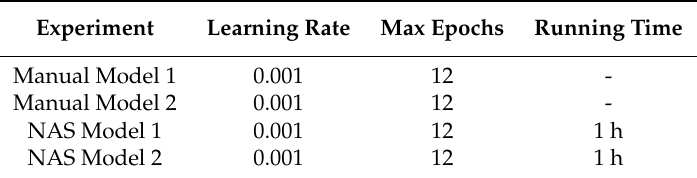
Table 3. Machine learning parameter settings for CNN.